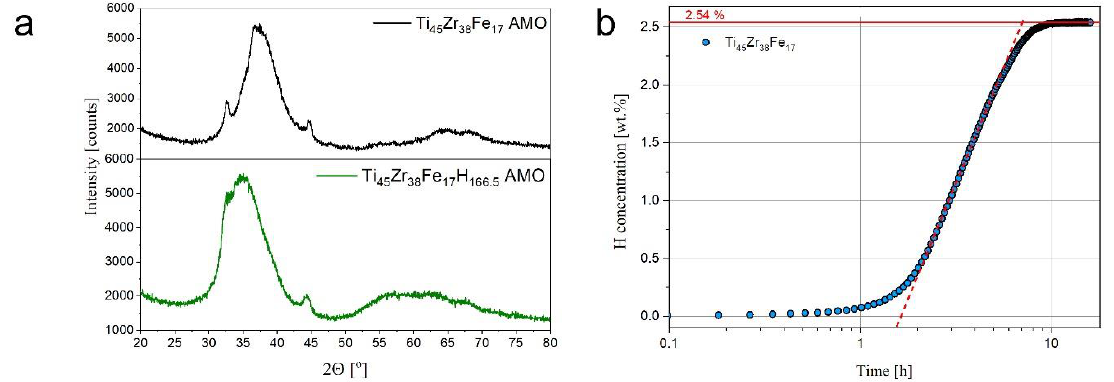
Figure 5. The diffraction patterns for the amorphous phase before (black) and after (olive) hydro- genation ( a ); hydrogen mass absorption vs. time for the amorphous TiZrFe ( b ).